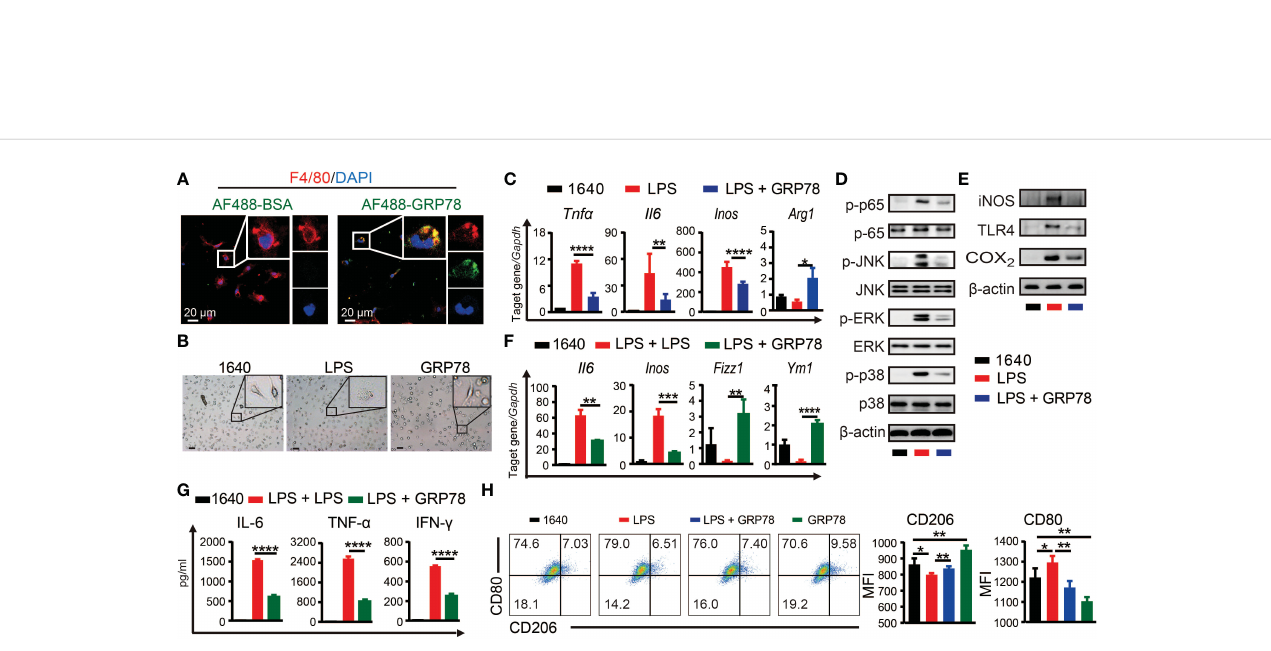
FIGURE 5 sGRP78 reverses LPS-induced macrophage M1 polarization in vitro. (A) Binding of recombinant mouse sGRP78 with F4/80 + BMDMs. Scale bar: 20 m m. (B) Representative photographs of BMDMs conditioned by sGRP78 (10 m g/ml) or LPS (100 ng/ml) for 24 h (magni fi cation 100×). Scale bar: 100 m m. (C) Levels of Arg1 , Tnf a , Il6 and Inos in peritoneal macrophages. Western blot analysis of the expression of MAPKs, p65 (D) , and TLR4, iNOS, COX 2 (E) of BMDMs. To further assess the effect of sGRP78 on LPS-induced macrophage, BMDMs were stimulated with LPS for 18 h and then with LPS or sGRP78 for another 12h (for mRNA detection F ) or 24h (for cytokine release, G ). (H) Levels of CD80 and CD206 on BMDMs. Error bars represent mean ± standard deviation from triplicate samples in one experiment. * p < 0.05, ** p < 0.01, *** p < 0.001, **** p < 0.0001.